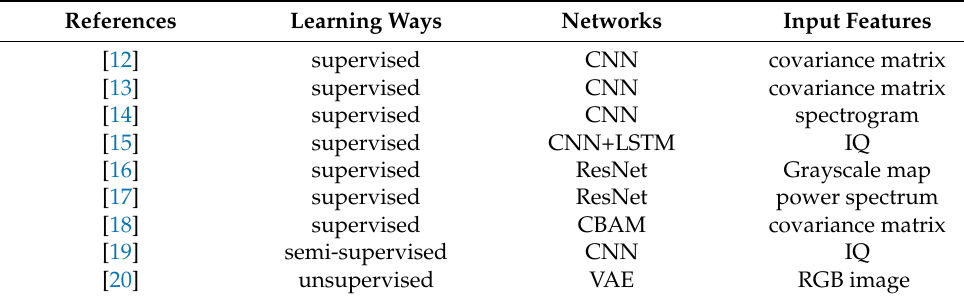
Table 1. Spectrum sensing algorithm based on deep